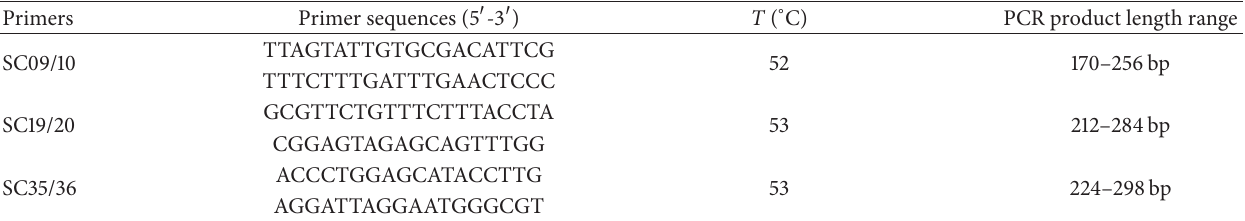
Table 2: Three pairs of primers designed and used well for duckweed ecotype identification. “ T ( ∘ C)” represents the degenerate temperature. Primers